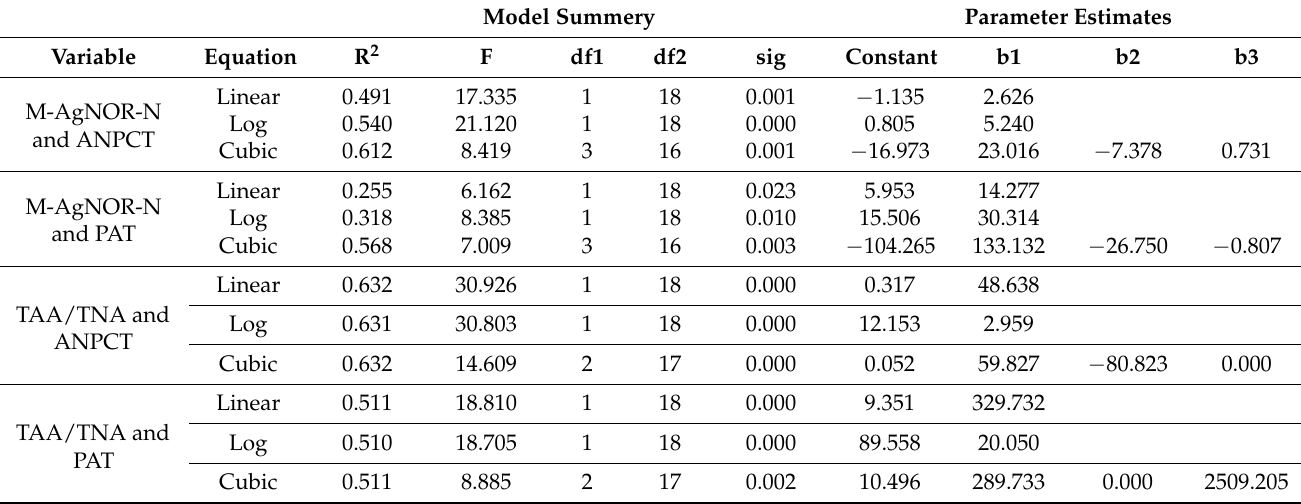
Table 5. Model summary and parameter estimates for AgNOR numbers, TAA/TNA, and antioxidant